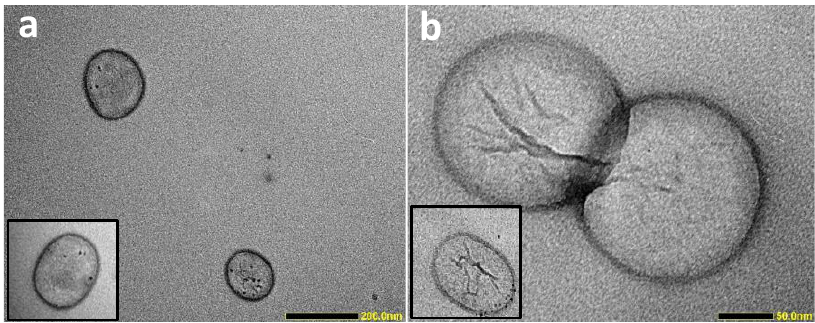
Figure 2. Structural elucidation of MLs. TEM images of MLs consist of ( a ) DOPC / DSPE-PEG 2000 (96 / 4) and ( b ) DSPC / Chol / DSPE-PEG 2000 (96 / 50 / 4). Scale bar is 200 nm and 50 nm, respectively.